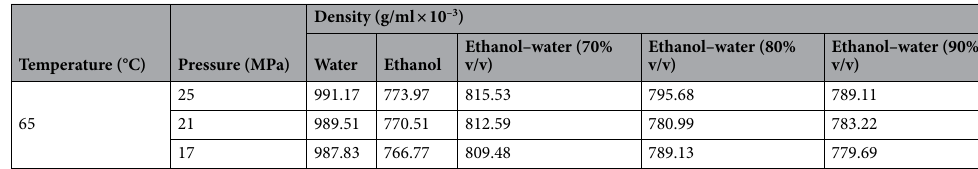
Table 8. Density of water, ethanol, and the ethanol–water mixture at different temperatures and pressures.